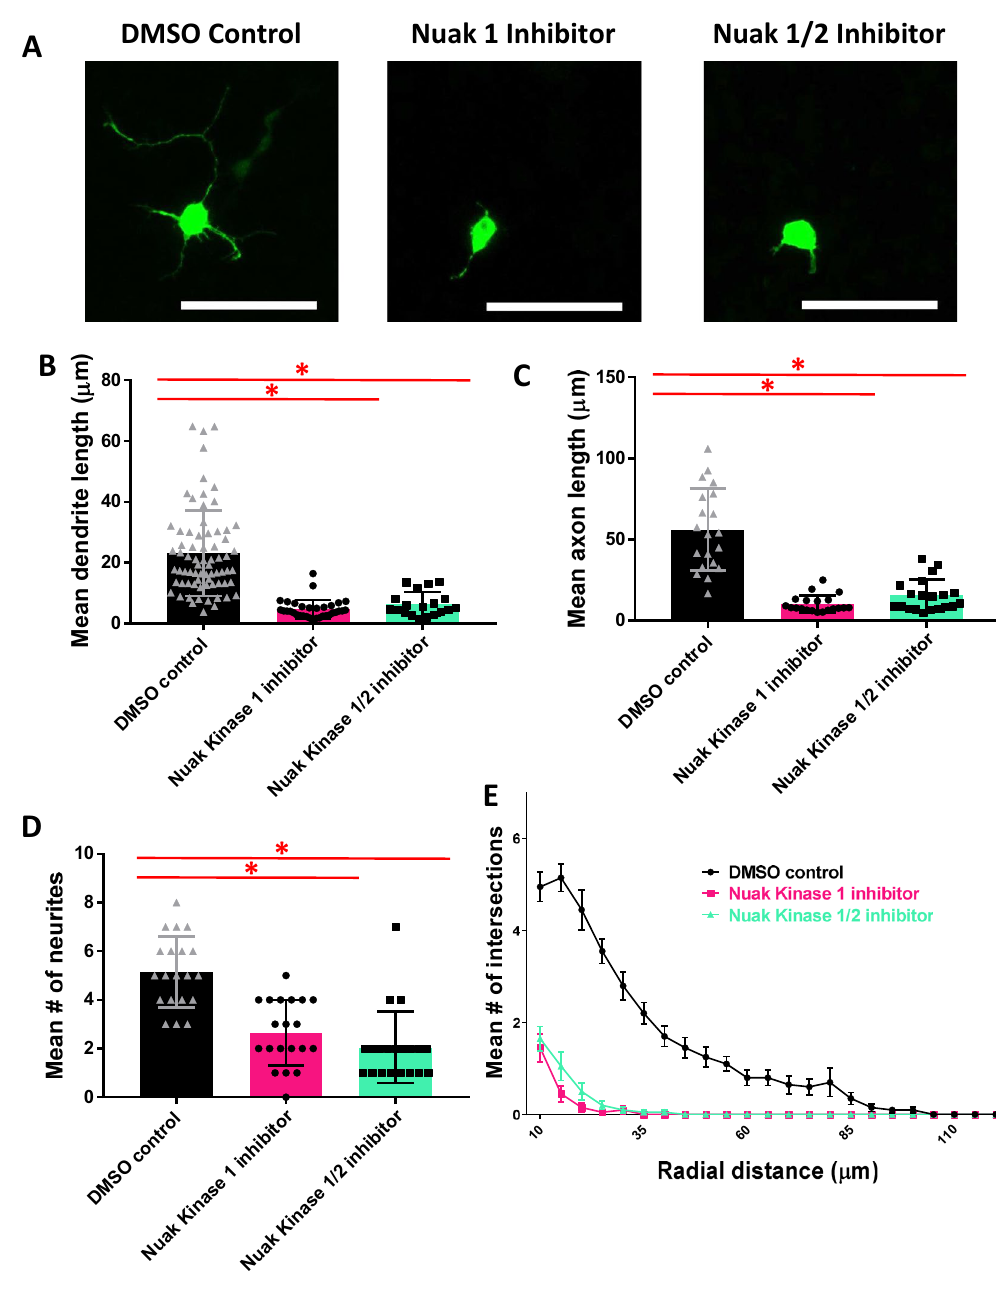
Figure 3. Inhibition of Nuak Kinases 1 and 1/2 in primary cortical neurons suggests roles for Nuak 1 and 2 in neurite initiation and elongation and arborization. ( A ) Primary cortical mouse neurons transfected with YFP and treated with Nuak kinase inhibitors, scale bars 50 µm. ( B ) One-way ANOVA determined there was a statistically significant difference in length of neurites likely to become dendrites [F(2, 120) = 39.341, p < 0.0005]. There was a statistically significant decrease in neurons treated with Nuak Kinase 1 inhibitor (4.7 ± 0.54, n = 33, p < 0.0005) and Nuak Kinase 1/2 inhibitor (6.48 ± 0.90, n = 19, p < 0.0005) as compared to the DMSO treated control (23.12 ± 1.67, n = 71). ( C ) One-way ANOVA determined there was a statistically significant difference in length of neurites likely to become axons [F(2, 57) = 49.832, p < 0.0005]. There was a statistically significant decrease in neurons treated with Nuak Kinase 1 inhibitor (10.3 ± 1.17, p < 0.0005) and Nuak Kinase 1/2 inhibitor (15.6 ± 2.19, p < 0.0005) as compared to the DMSO treated control (56.2 ± 5.64). For all groups, n = 20. ( D ) One-way ANOVA determined there was a statistically significant difference in mean number of neurites [F(2, 57) = 26.556, p < 0.0005]. There was a statistically significant decrease in neurons treated with Nuak Kinase 1 inhibitor (2.65 ± 0.30, p < 0.0005) and Nuak Kinase 1/2 inhibitor (2.05 ± 0.33, p < 0.0005) as compared to the DMSO treated control (5.15 ± 0.33). For all groups, n = 20. ( E ) Sholl analysis shows dramatic decrease in branching for neurons treated with Nuak Kinase 1 and 1/2